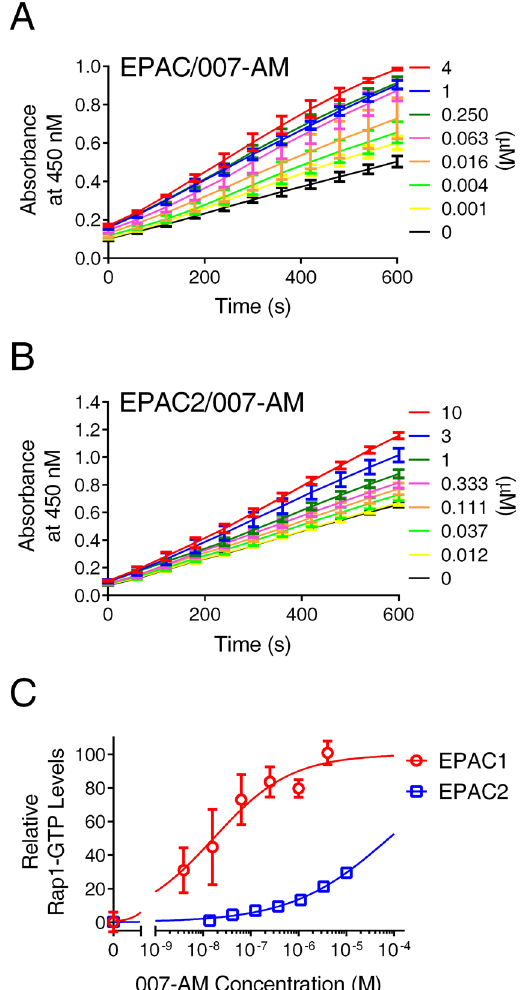
Figure 4. Dose-dependent cellular activation of EPAC1 and EPAC2 by 007-AM. ( A ) Time course of EPAC1-mediated Rap1 activation in response to 007-AM stimulation. ( B ) Time course of EPAC2-mediated Rap1 activation in response to 007-AM stimulation. ( C ) Relative Rap1-GTP levels as a function of 007- AM concentration in HEK293 cells overexpressing EPAC1 or EPAC2, respectively. Data are presented as Means ± SD, n =